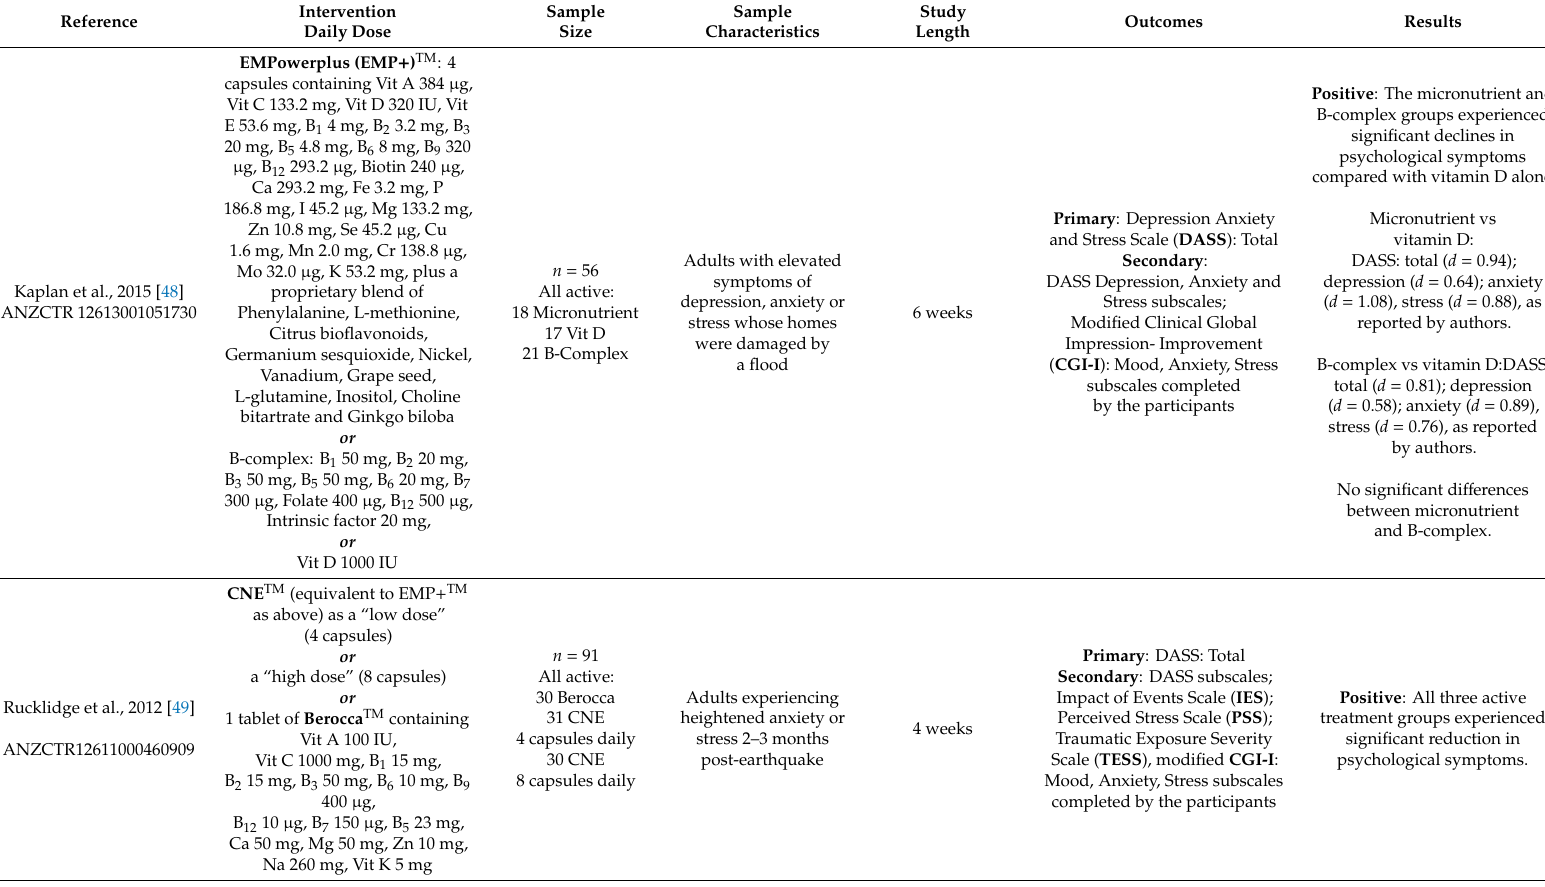
Table 3. Post-natural disaster stress studies ( n =